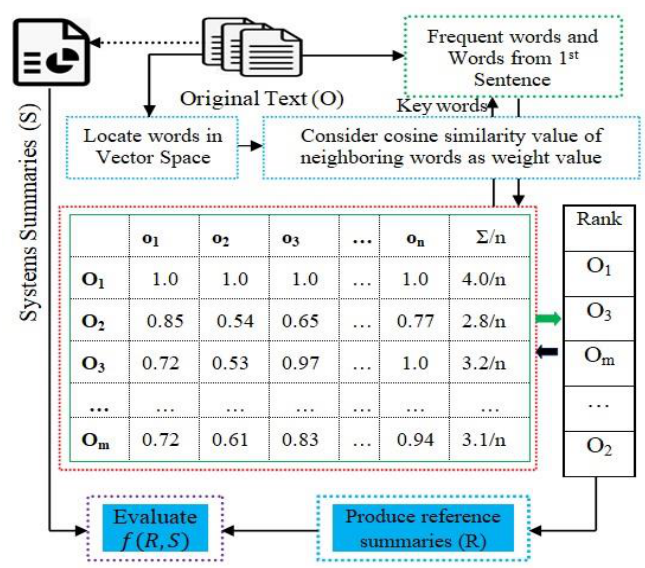
Figure 1. The general workflow architecture of proposed framework for automatic text summarization and evaluation. Given original sentences O = O 1 , O 2 , O 3 ... O m with their corresponding sequence of words o ij = o i1 , o i2 , o i3 ... o in , assign the highest cosine similarity value to the words by comparing them with the keywords. Keywords are nonstop words from first sentence of the original document and top k number of frequent words from the document, (we experimented with values between 1 and 15, and found the optimal value to be k = 6). Then sum up all weights ( Σ ) and divide by the number of words (n) in the corresponding sentence for ranking. Then top-y sentences are considered as a reference summary.